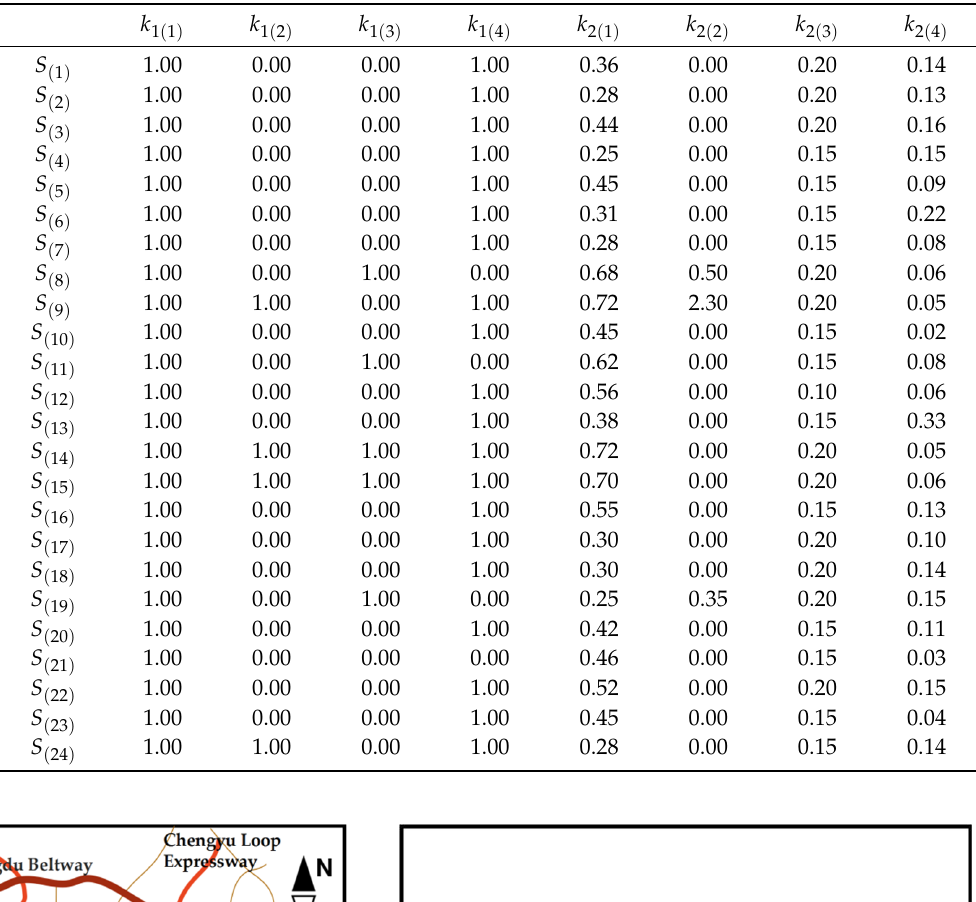
Table 1. Scenic water spot normalized classifications and attributes.